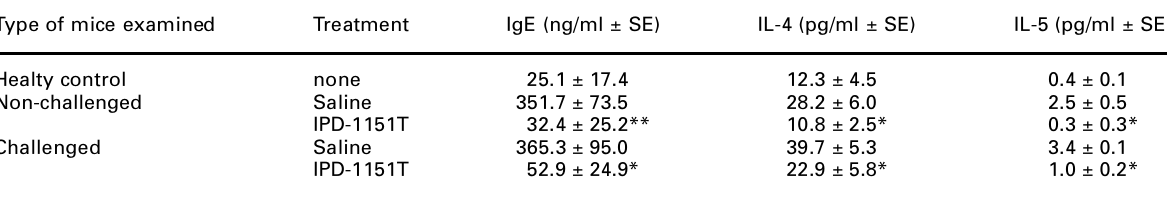
Table 1. Effects of IPD-1151T on production of IgE, IL-4 and IL-5 in BALB/c mice immunized by DNP-OVA Type of mice